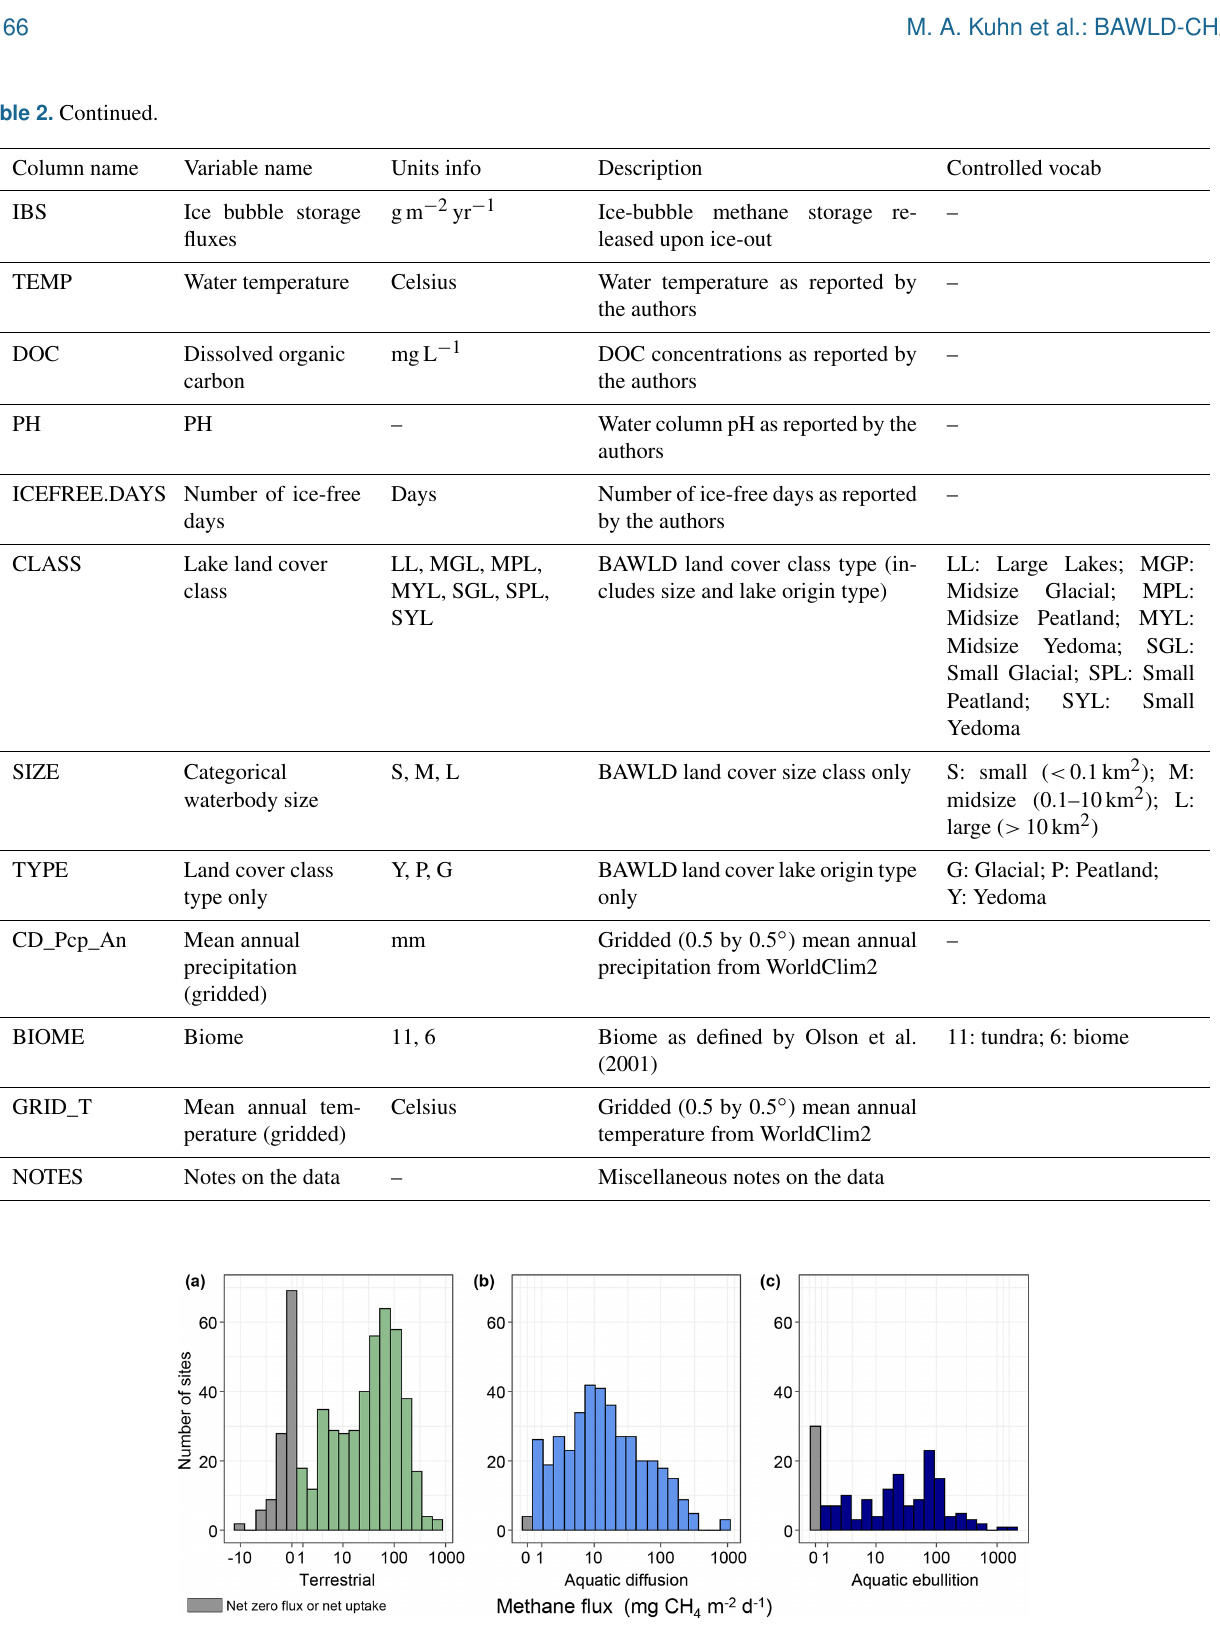
Figure 5. Histograms of site-specific average CH 4 fluxes. (a) Terrestrial fluxes. (b) Aquatic diffusive fluxes. (c) Aquatic ebullitive fluxes. Grey bars represent net zero or net uptake